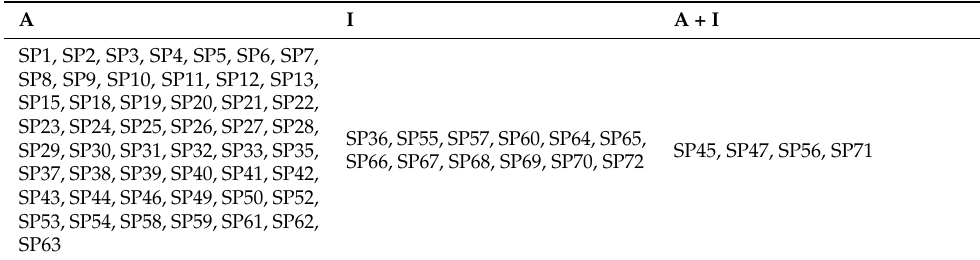
Table 12. Selected papers and origins of the